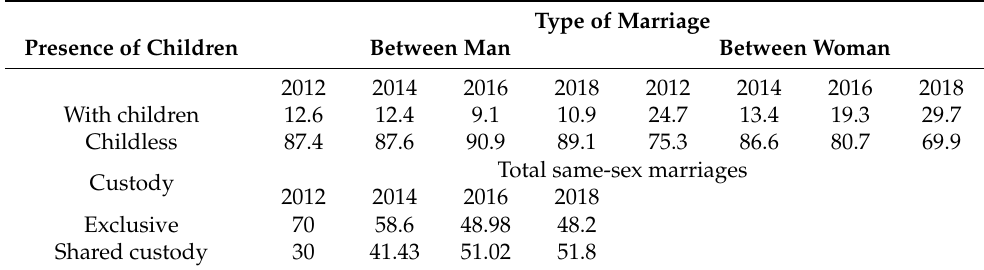
Table 4. Presence of minor children in the divorce of same-sex couples in Spain and assigned custody modality (%). Type of Marriage Presence of Children Between Man Between Woman 2012 2014 2016 2018 2012 2014 2016 2018 With children 12.6 12.4 9.1 29.7 Childless 87.4 87.6 69.9 Total same-sex marriages Custody 2012 2014 2016 2018 Exclusive 70 58.6 48.98 48.2 Shared custody 30 41.43 51.02